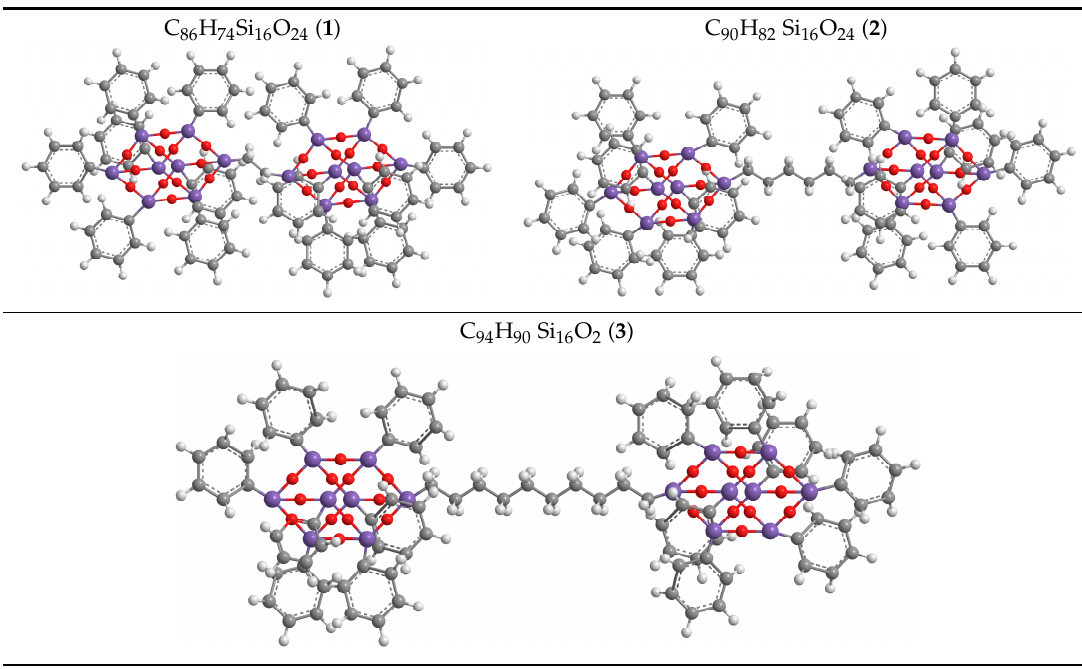
Table 1. ( 1 ), ( 2 ) and ( 3 ) dumbbell-shaped octaphenyl polyhedral oligomeric silsesquioxanes (POSSs) structures, with aliphatic bridge, used in polystyrene (PS) nanocomposites.